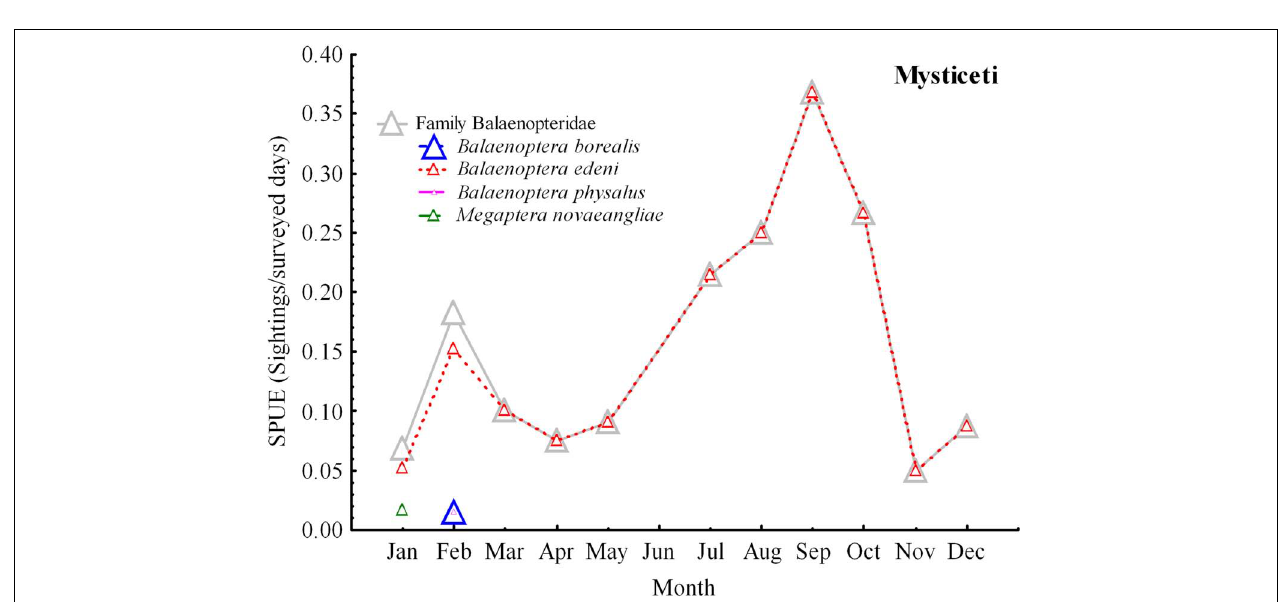
FIGURE 4 | Temporal variation of total Odontoceti sightings per unit effort (SPUE; sighting/surveyed days) in the Canary Islands during the study period (Jan. 2007–Dec. 2018). Blue line: Family Zipphiidae; green line: Family Kogiiidae; pink line: Family Physeteridae; black line: Family Delphinidae.